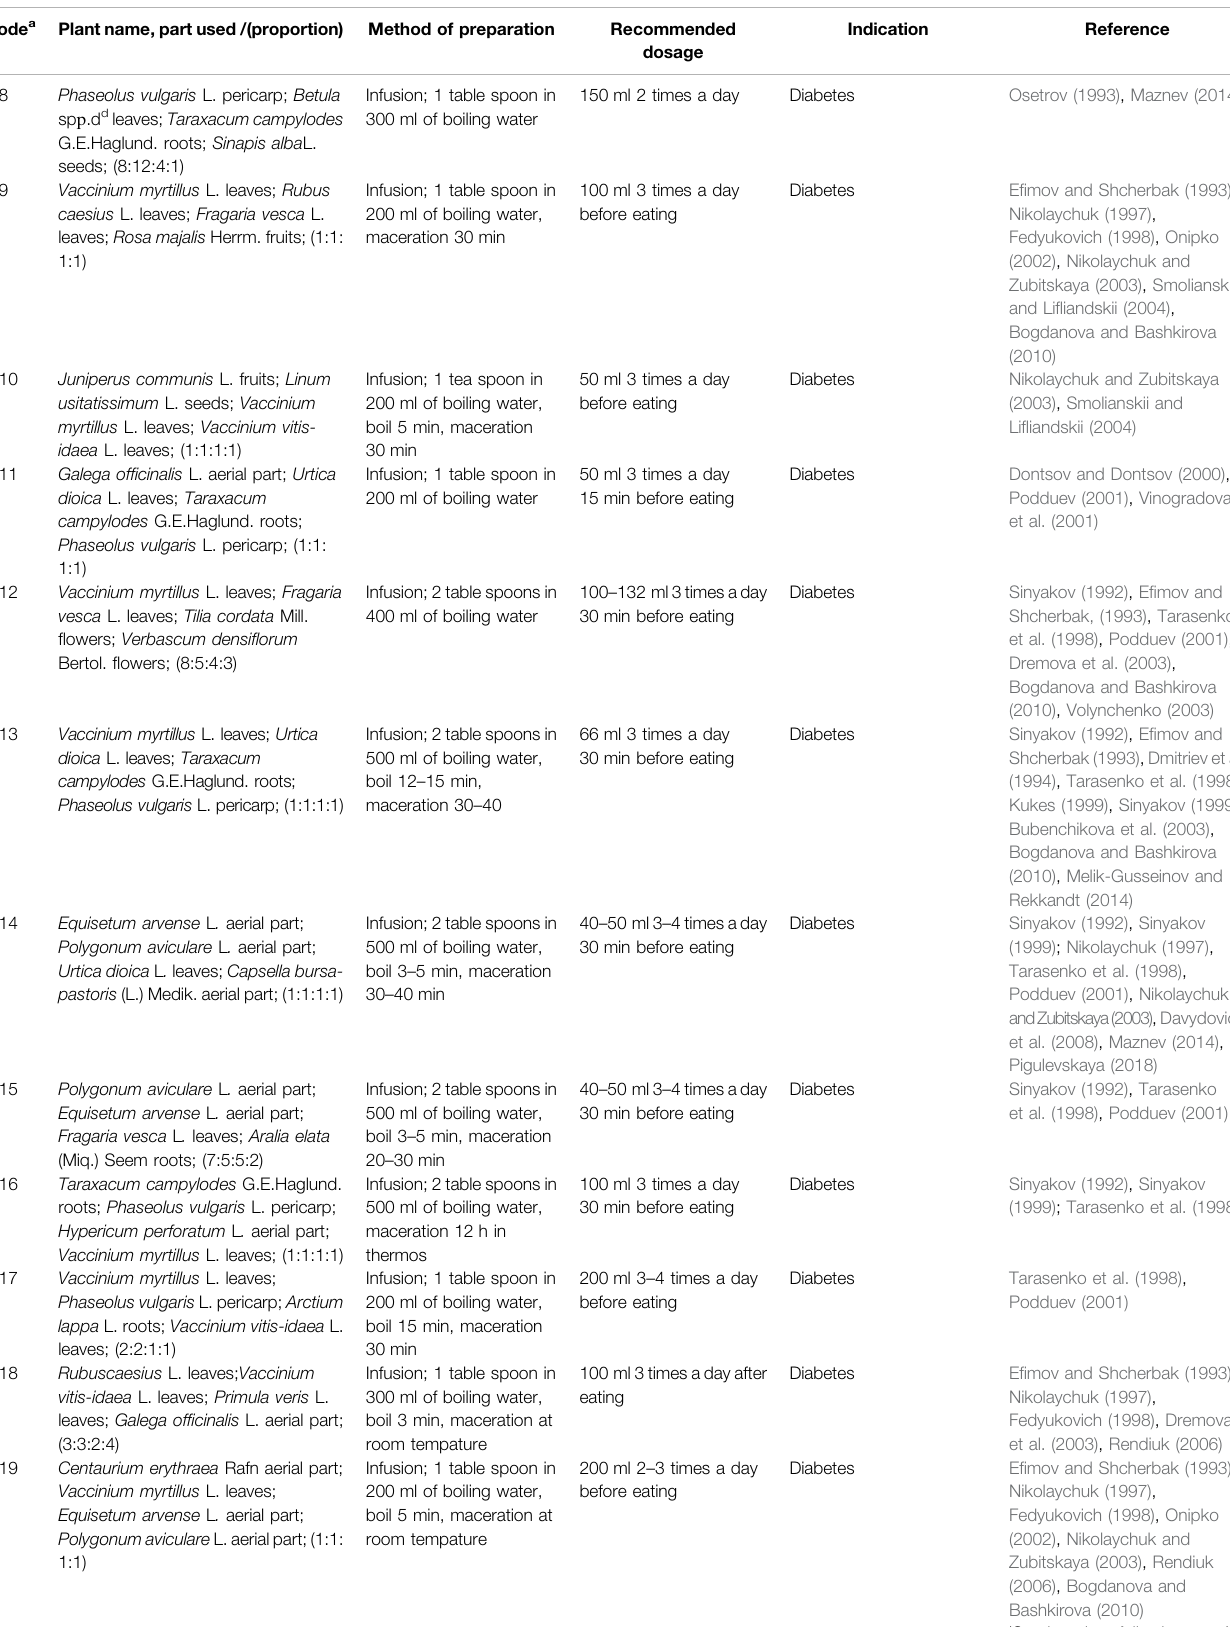
TABLE 1 | ( Continued ) The list of medical species used for the management of diabetes and related disorders in Russia. Code a Plant name, part used /(proportion) Method of